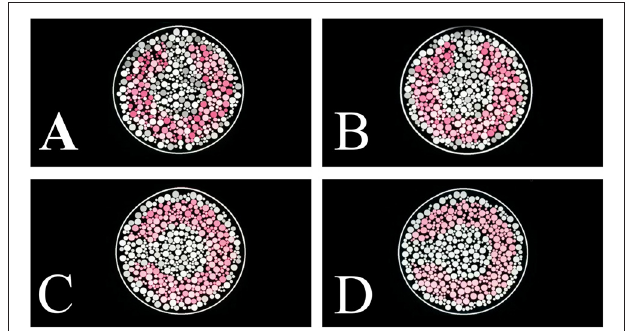
FIGURE 1 | Pseudoisochromatic stimulus examples with different luminance noise range conditions. (A) Luminance noise ranged between 6 cd/m 2 and 20 cd/m 2 (amplitude of 14 cd/m 2 ). (B) Luminance noise ranged between 8 cd/m 2 and 18 cd/m 2 (amplitude of 10 cd/m 2 ). (C) Luminance noise ranged between 10 cd/m 2 and 16 cd/m 2 (amplitude of 4 cd/m 2 ). (D) Luminance noise ranged between 12 cd/m 2 and 14 cd/m 2 (amplitude of 2 cd/m 2 ).